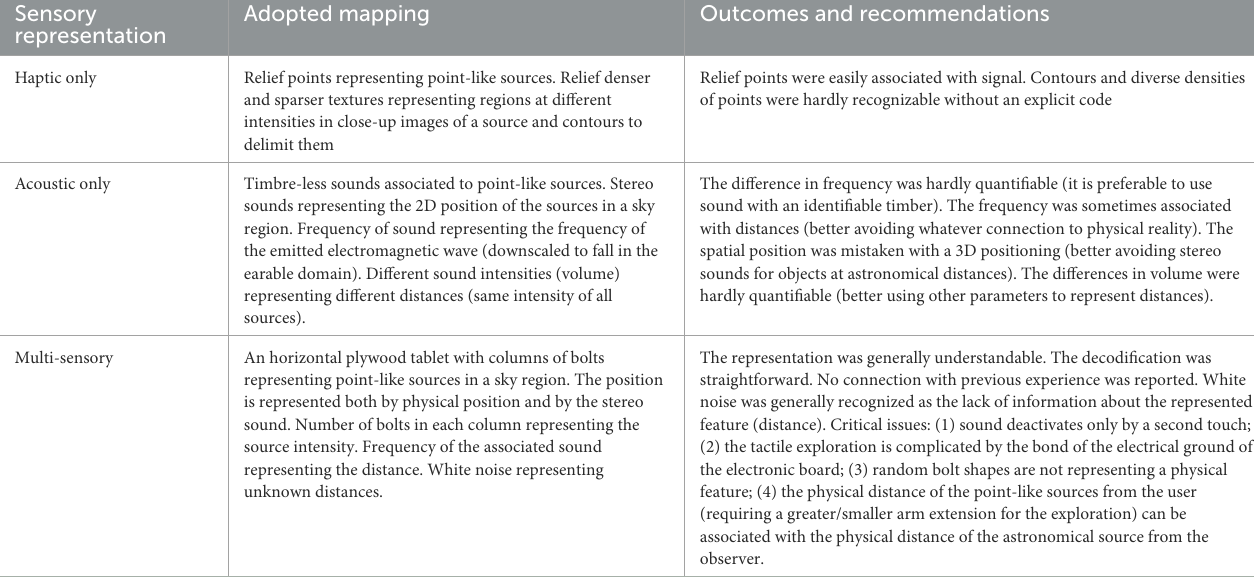
(Figure 1). We represented the point-like sources on the first map with relief